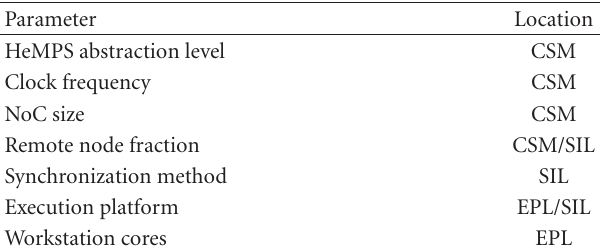
Table 1: Variable benchmark